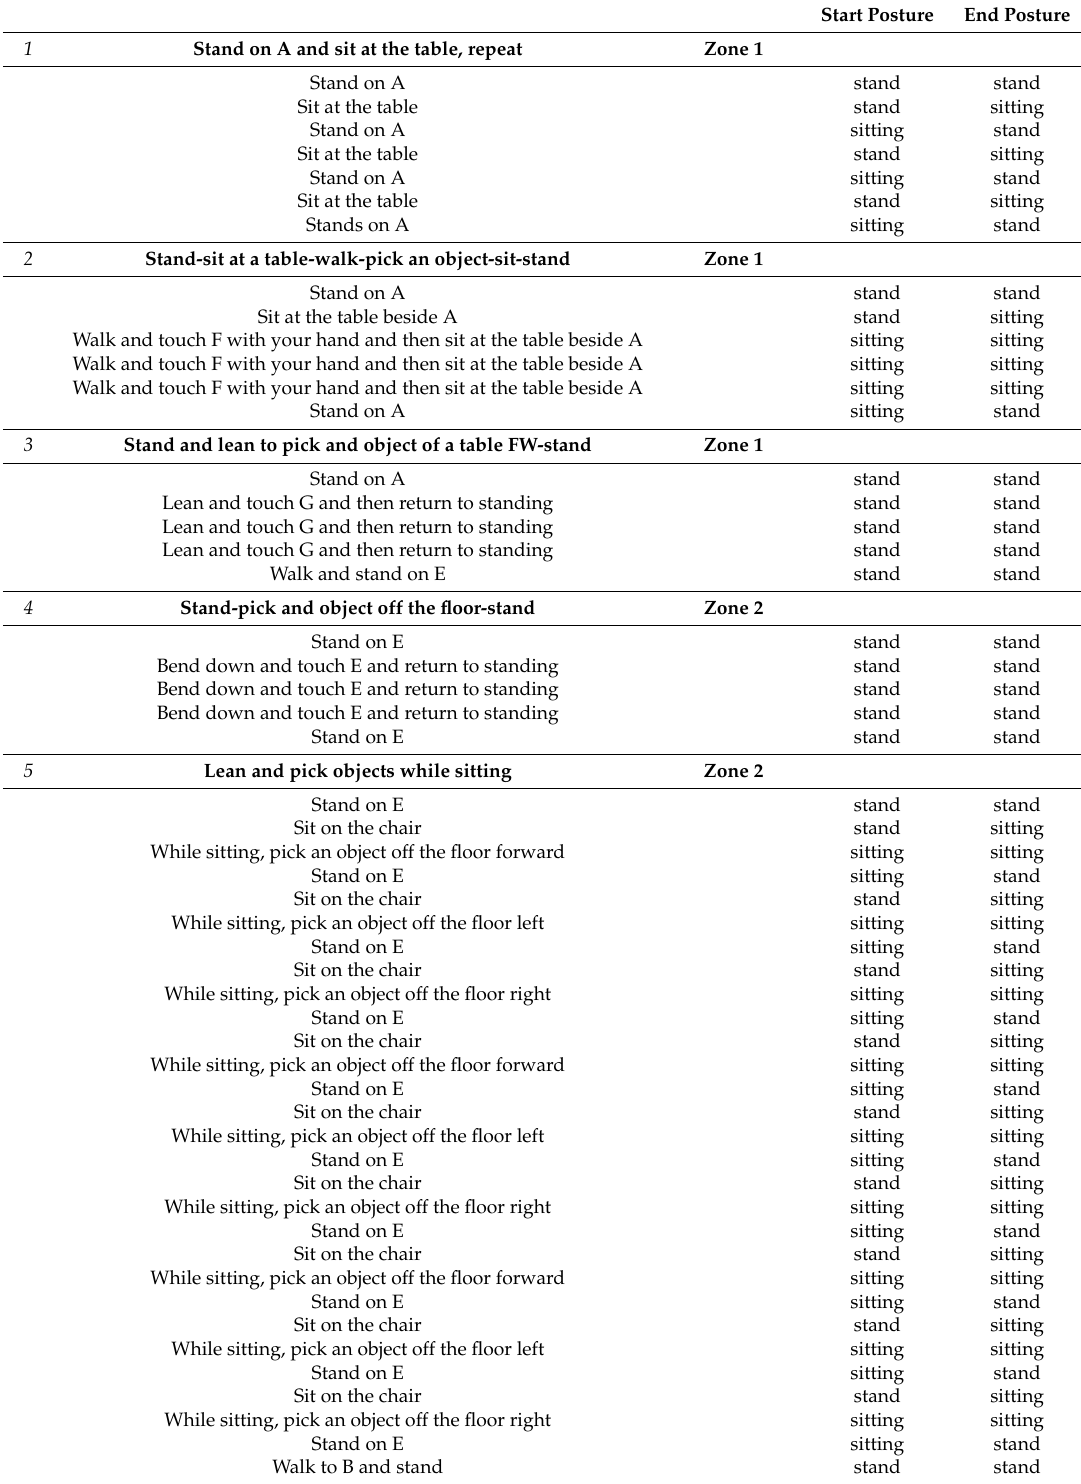
Table A3. The instruction set for the semi-structured task-based